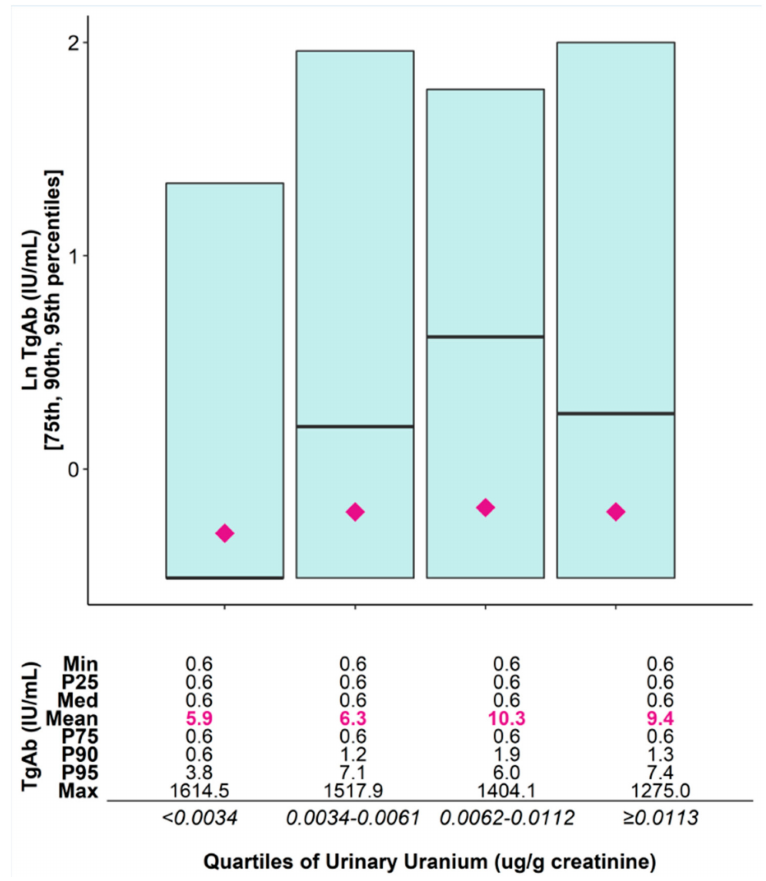
Figure 2. Ln-transformed serum concentration of thyroglobulin antibodies (TgAb) (IU / mL) per quartile of creatinine-adjusted urinary uranium ( µ g / g creatinine).